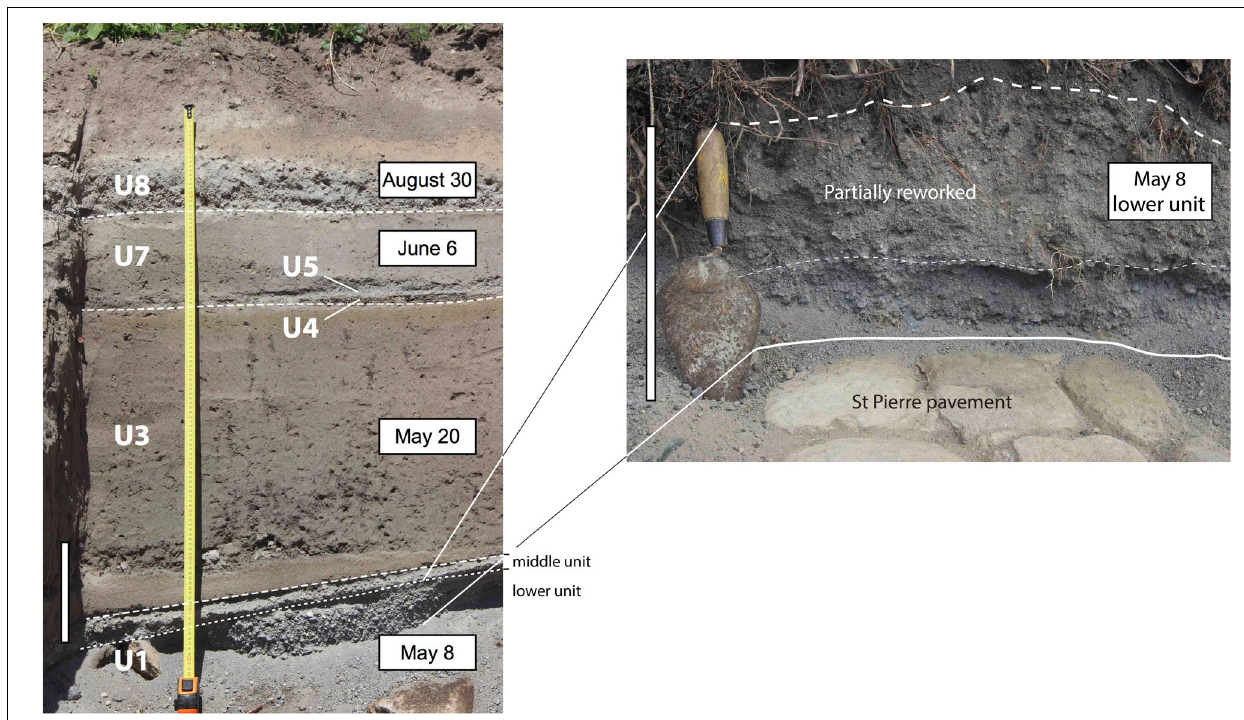
FIGURE 4 | Fine-grained facies of the May 8th, May 20th, June 6th, and August 30th deposits in the Fort district (St Pierre). Units U1 to U8 are from Bourdier et al. (1989). Unit U1, corresponds to the May 8th deposit, separated in three layers, i.e., the lower, middle and upper unit (see text for description). Only the middle and lower unit are visible at St Pierre. The picture on the right is a closer view of the U1 lower layer, sampled in the northern part of St Pierre (yellow star in Figure 2 ) where the deposit is directly in contact with the pavement of the city. The white scale bar is 20 cm long.